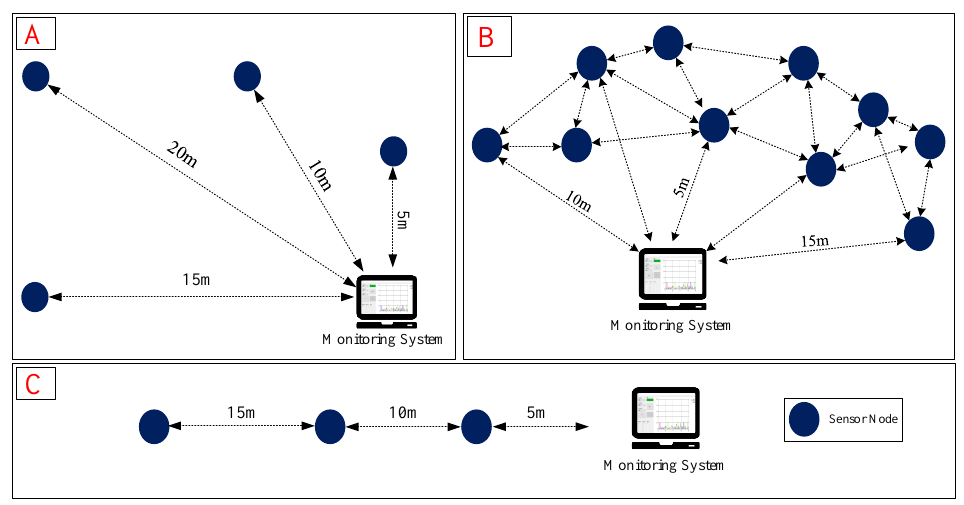
Figure 10. Outdoor wireless test of ( A ) Point-to-Point; ( B ) Mesh and ( C ) End-to-End modes .